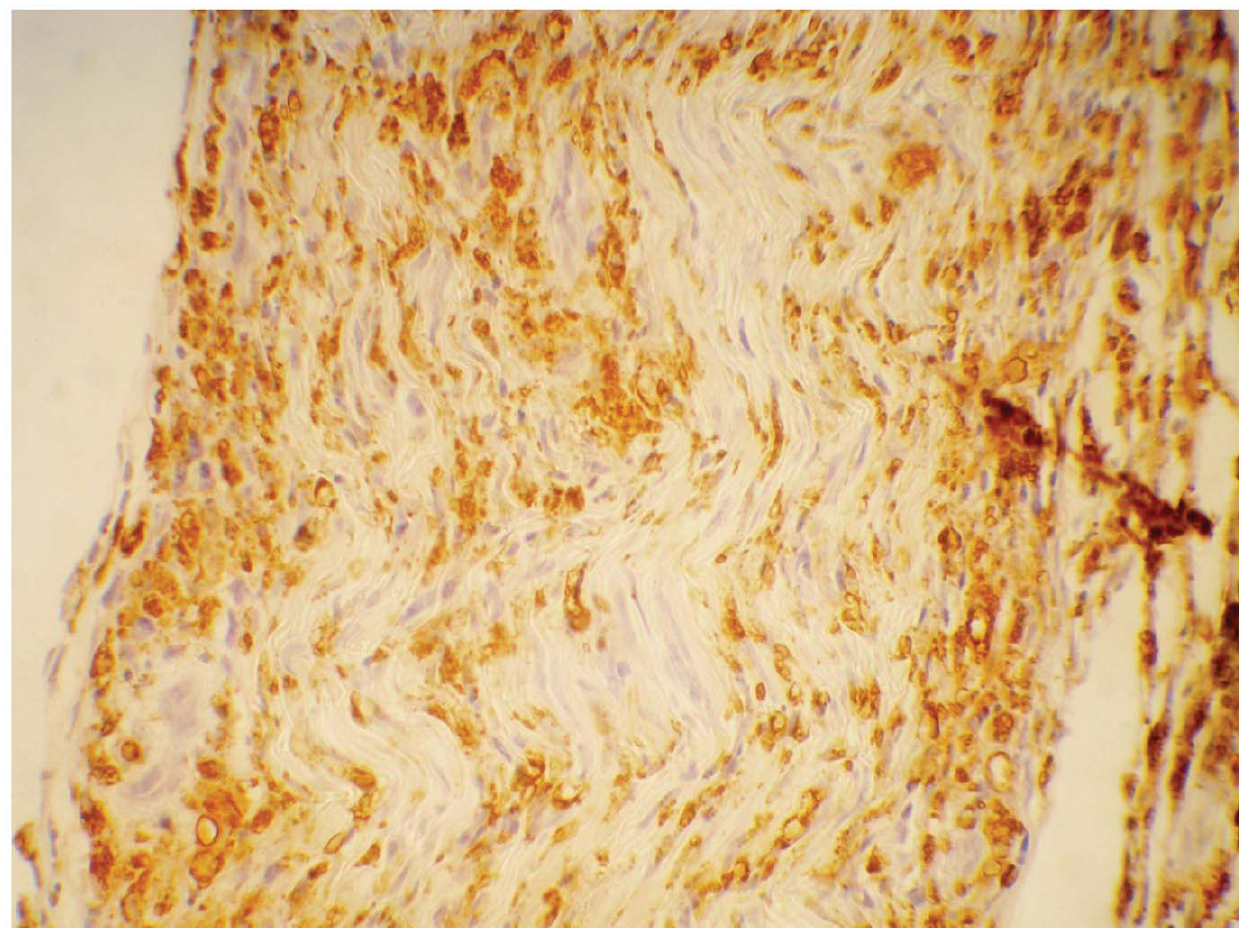
Figure 6. Nerve stained for CD68 cells. Nerve showing CD68 positive macrophages. IHC staining 6 40.